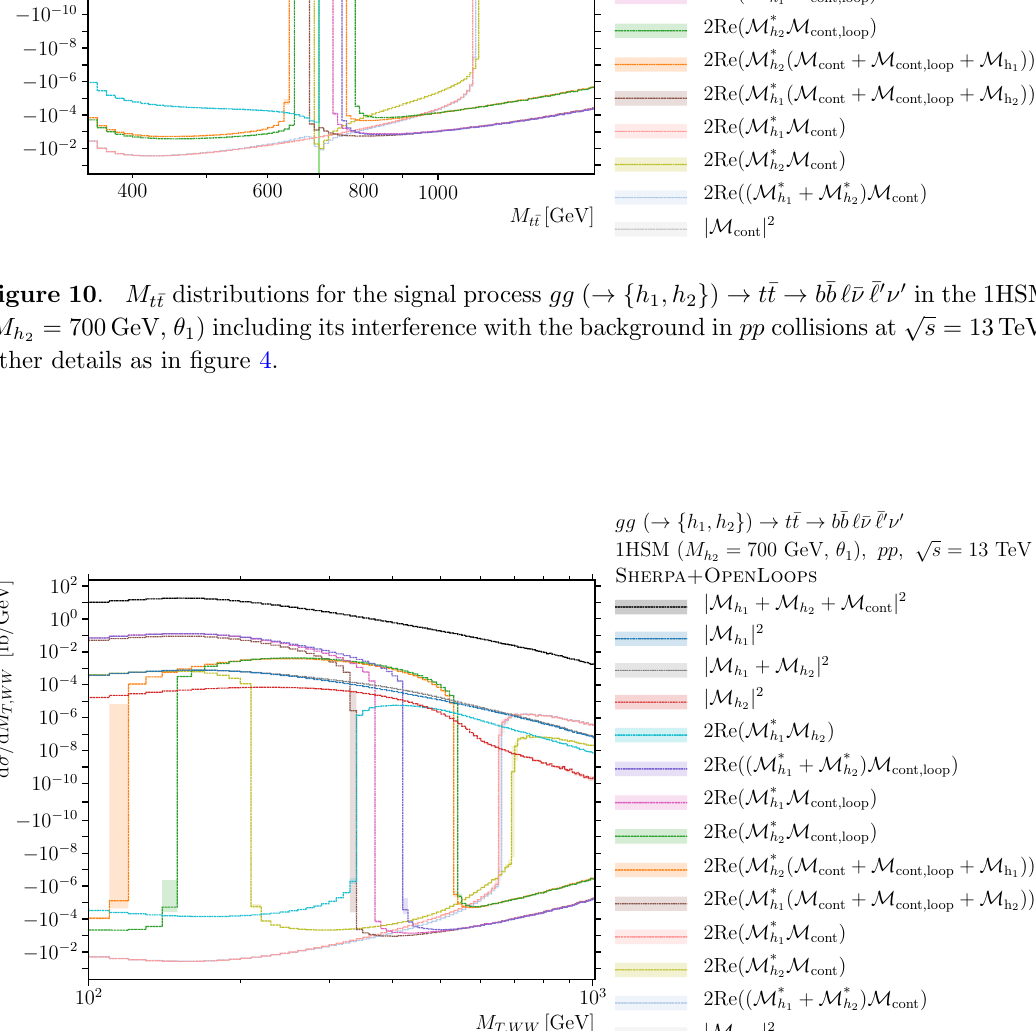
Figure 11 . M T,WW distributions for the signal process gg ( → { h 1 , h 2 } ) → t = 700 GeV, θ 1 ) including its interference with the background in pp collisions at the 1HSM ( M h 2 √ s = 13 TeV. Other details as in figure